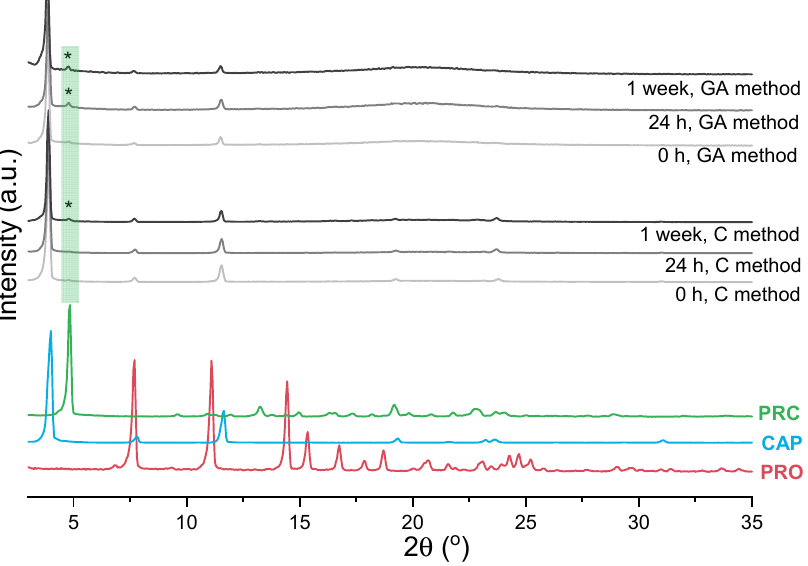
Figure 7. PXRD patterns of PRO, CAP (analysed as received), PRC (recrystallised from ethanol) and samples prepared by either co-grinding PRO and CAP in agate pestle and mortar at 0.2 mol of PRO at 4 °C (grinding-assisted (GA) method) or gentle mixing of PRO and CAP at 0.2 mol of PRO at 4 °C with a spatula at 4 °C (contact (C) method). Stars (*) indicate the characteristic peak of PRC.